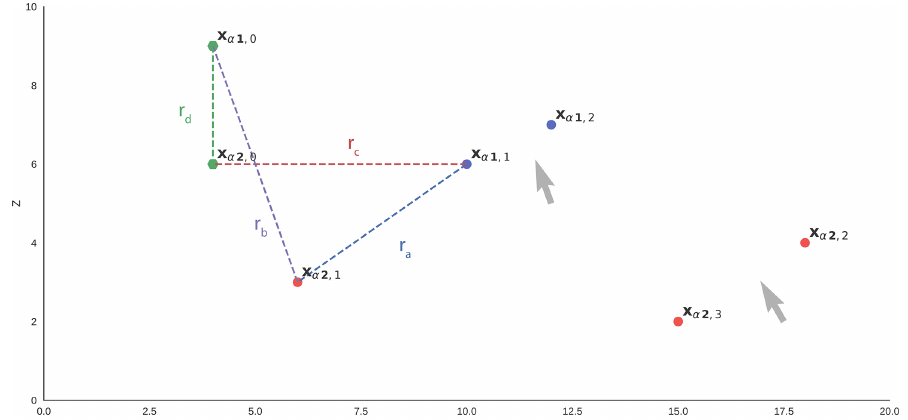
Figure B2. Distances r involved in the computation of the interface subsystem of the interpolation. Because all covariances are relative to a reference point x i , all four covariances with their respective distances, r a , r b , r c and r d , must be taken into account (Eq. α, 0